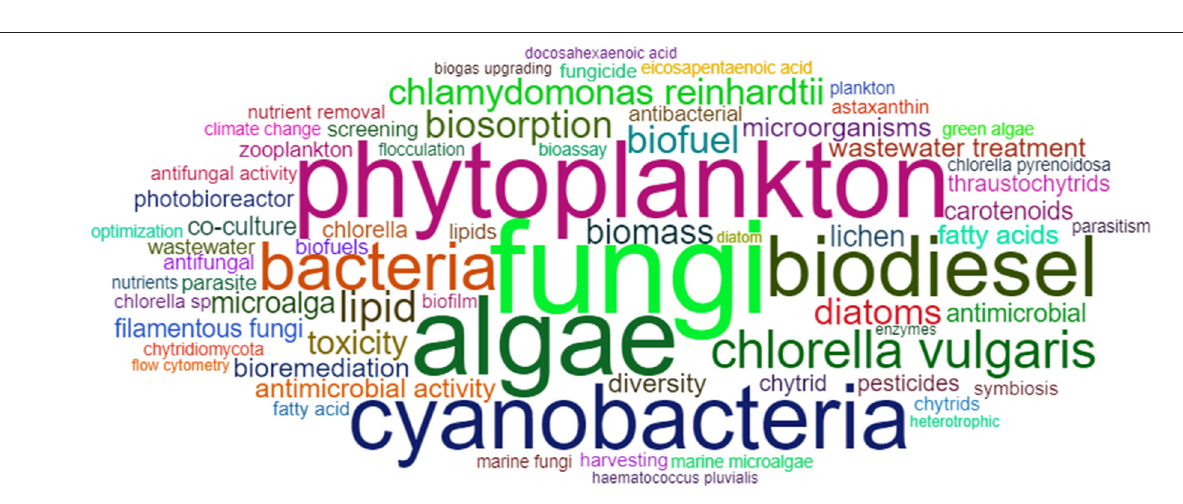
FIGURE 6 | Most-cited keywords of microalgae-fungi consortia